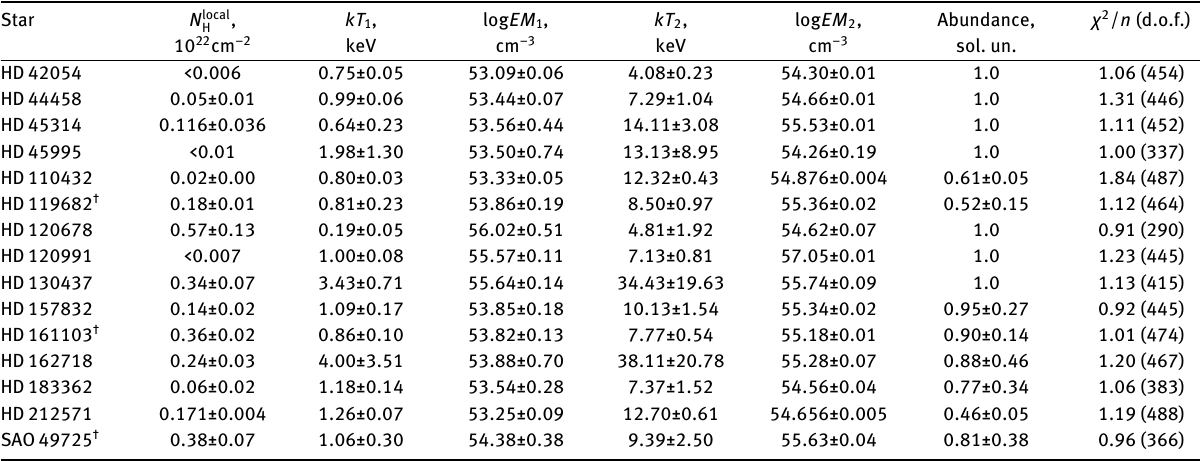
Table 3. Results from the spectral fits for the APEC/MEKAL